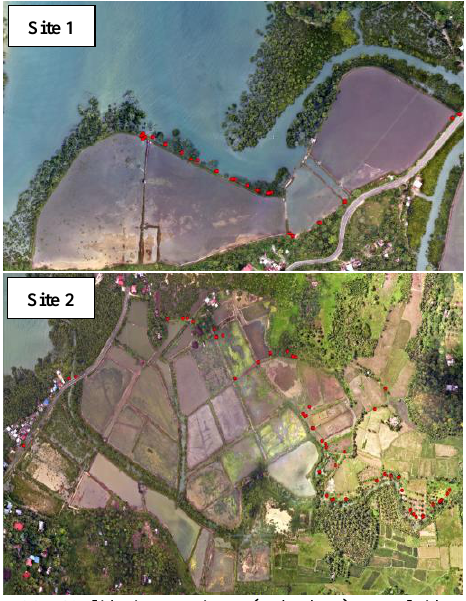
Figure 11. Validation points (red dots) overlaid on the